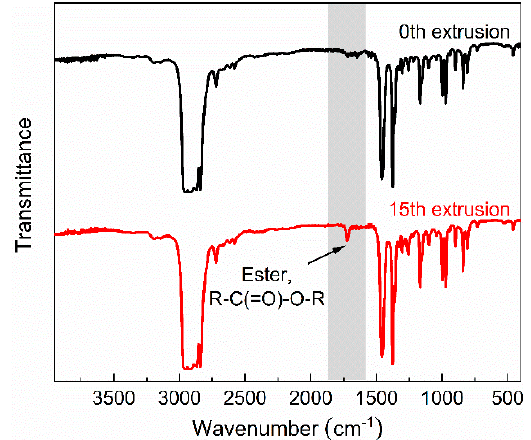
Figure 7. FTIR spectra of PP with different numbers of extrusions.